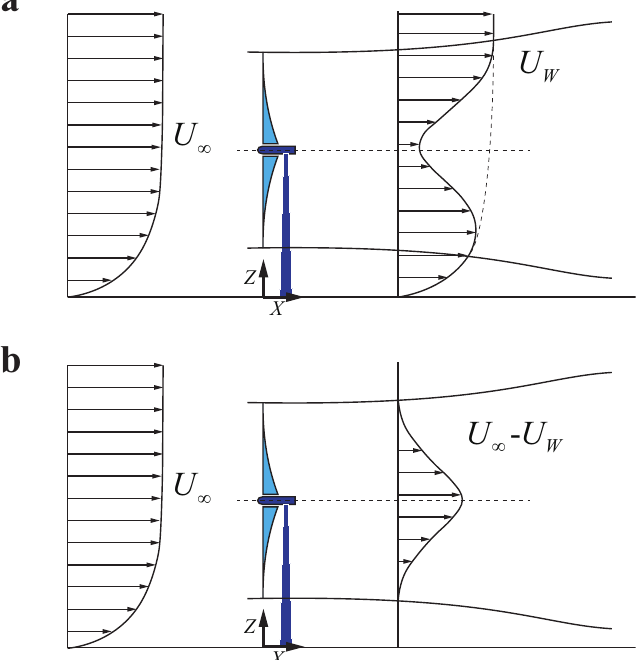
Figure 11. Schematic of the vertical profile of ( a ) streamwise velocity and ( b ) velocity